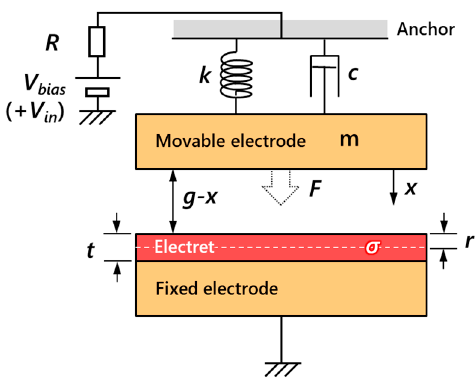
Figure 4. Electromechanical modeling of gap-closing parallel plate electrodes with electret. Table 1. Parameters used for gap-closing parallel plate electrode model simulation